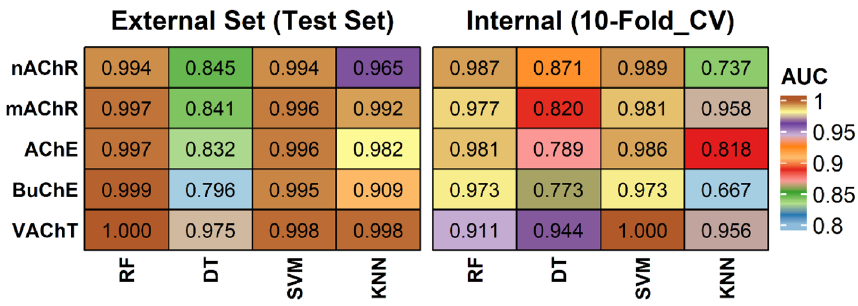
Figure 5. Statistical performance of DTI classification models. The area under receiver operating characteristic curve (AUC) was calculated in external and internal validation of respective